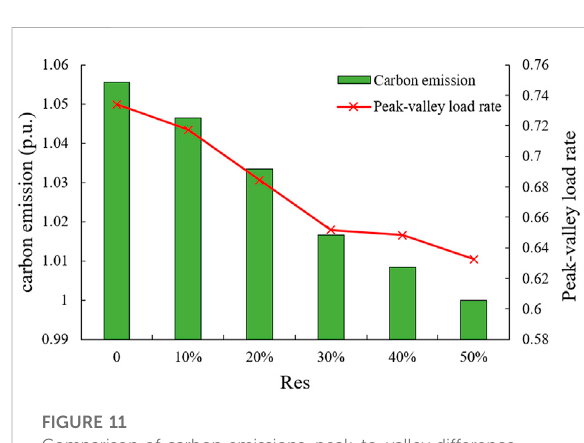
FIGURE 11 Comparison of carbon emissions, peak-to-valley difference rate under different responsiveness of EV.